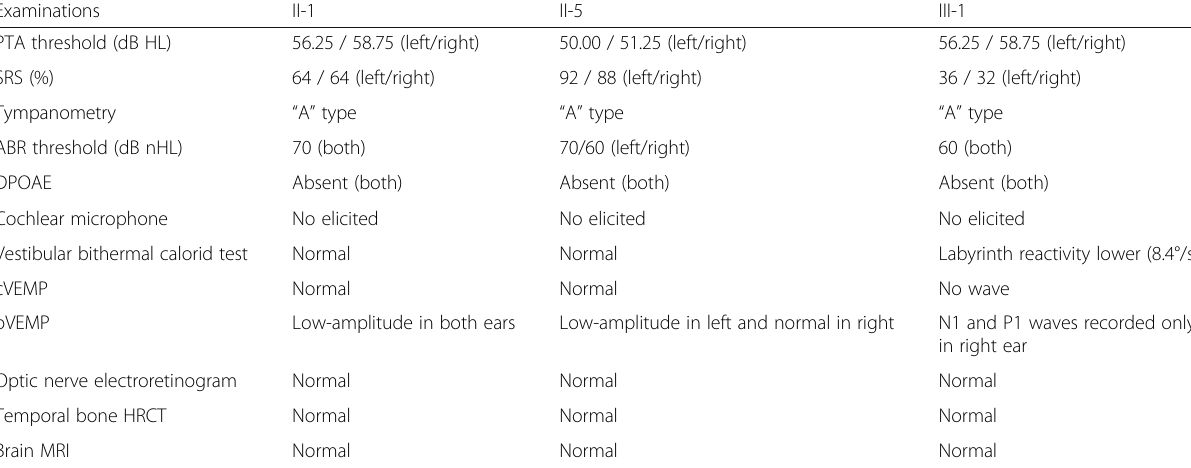
Table 1 Clinical features of individuals with sensorineural hearing loss in this family